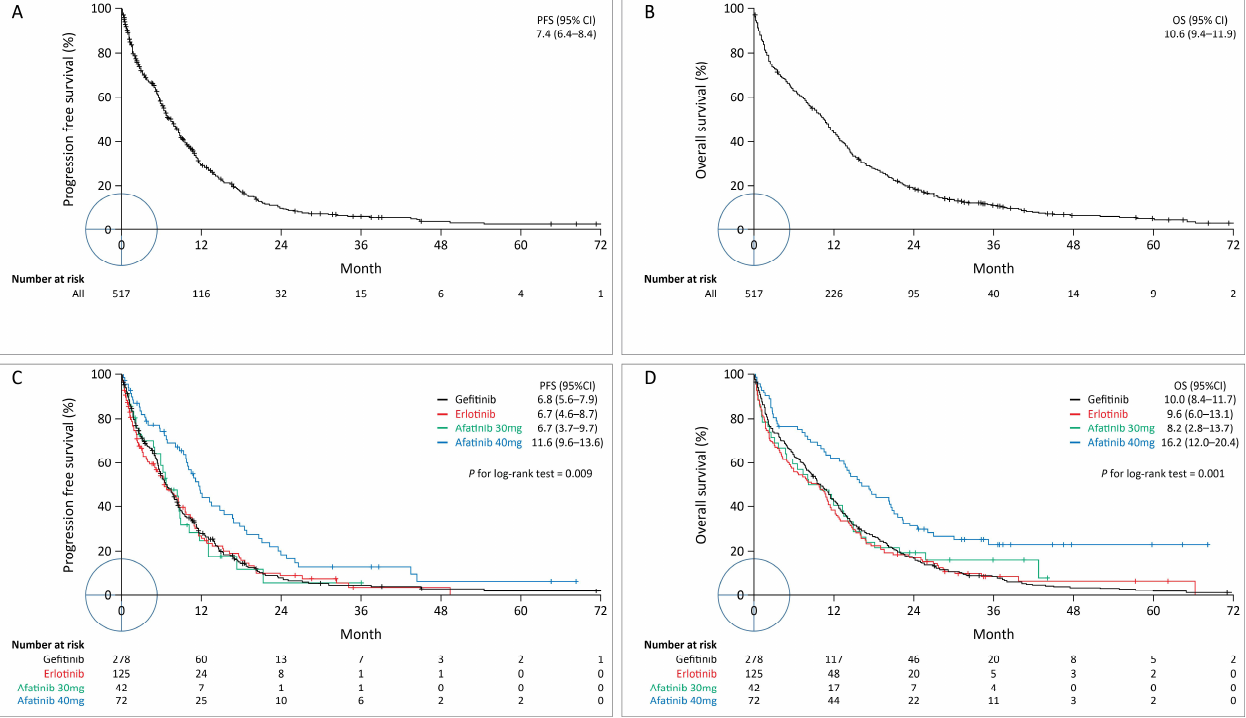
Figure 2. Kaplan–Meier survival curves indicating PFS ( A , C ) and OS ( B , D ) for all patients ( A , B ) and stratified according to the different EGFR-TKIs ( C , D ). EGFR-TKIs, epidermal growth factor receptor tyrosine kinase inhibitors; OS, overall survival; PFS, progression-free survival.